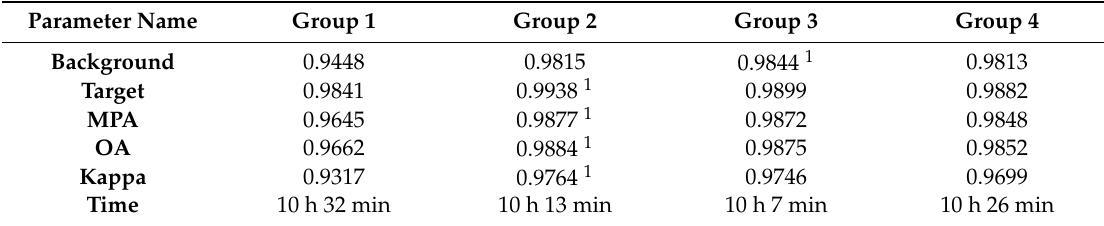
Table 5. Classification accuracy of different groups under uniform distribution of strong and weak signals.